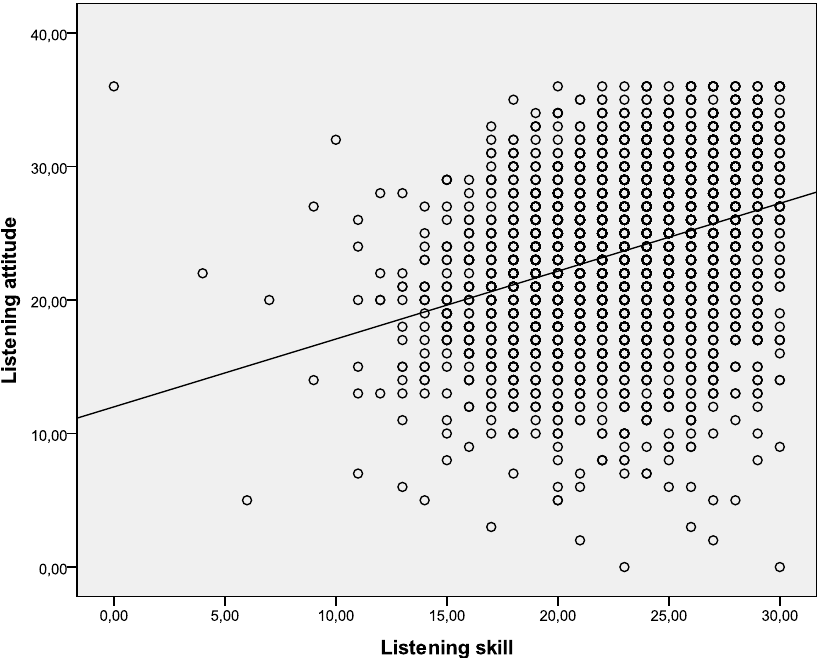
Figure 2. Scatter plot for the association of Listening Attitude with Listening Skill.